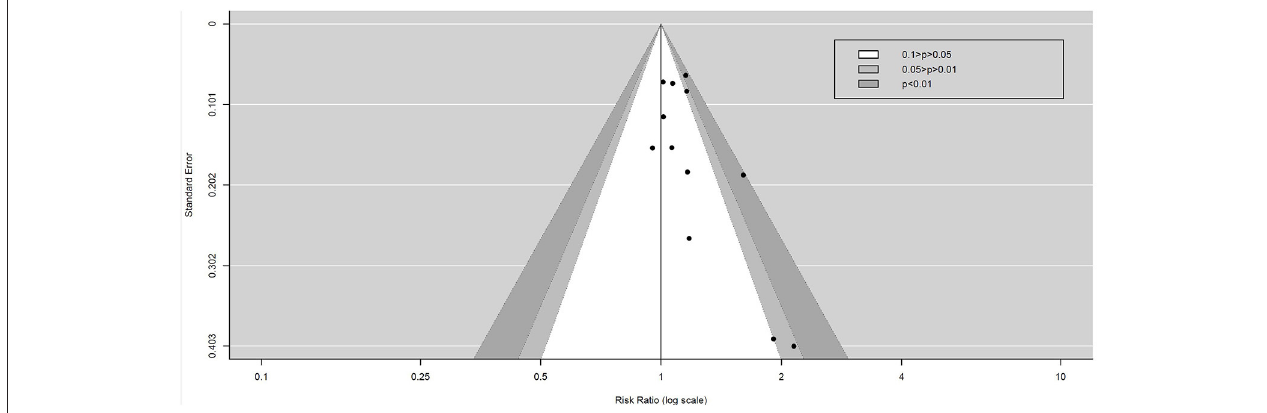
FIGURE 9 | Contour-enhanced funnel plot assessed the potential publication bias.